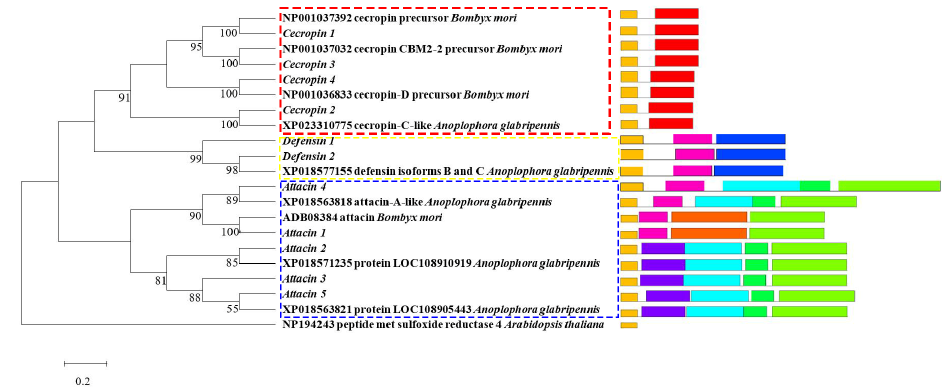
Figure 1. Phylogenetic analysis of M. alternatus AMP